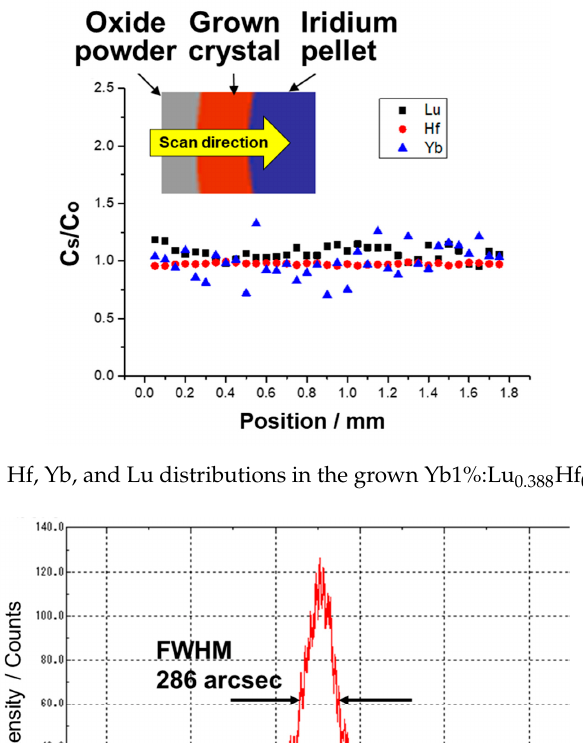
Figure 4. Results of powder X-ray diffraction (XRD) of the grown Yb1%:Lu 2 O 3 , Yb1%:Lu 0.388 Hf 0.612 O 1.806 , and Yb1%:Lu 0.18 Hf 0.82 O 1.91 .